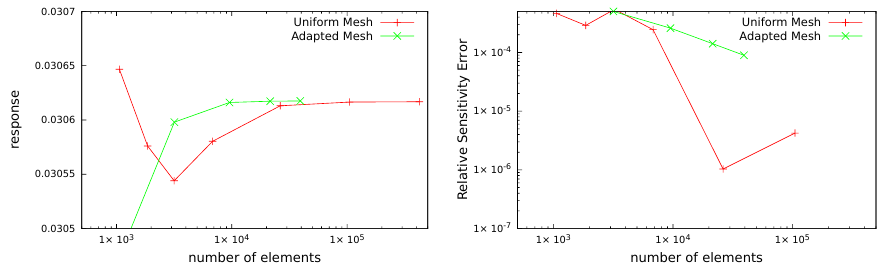
Figure 4. Response against mesh size using uniform and adapted